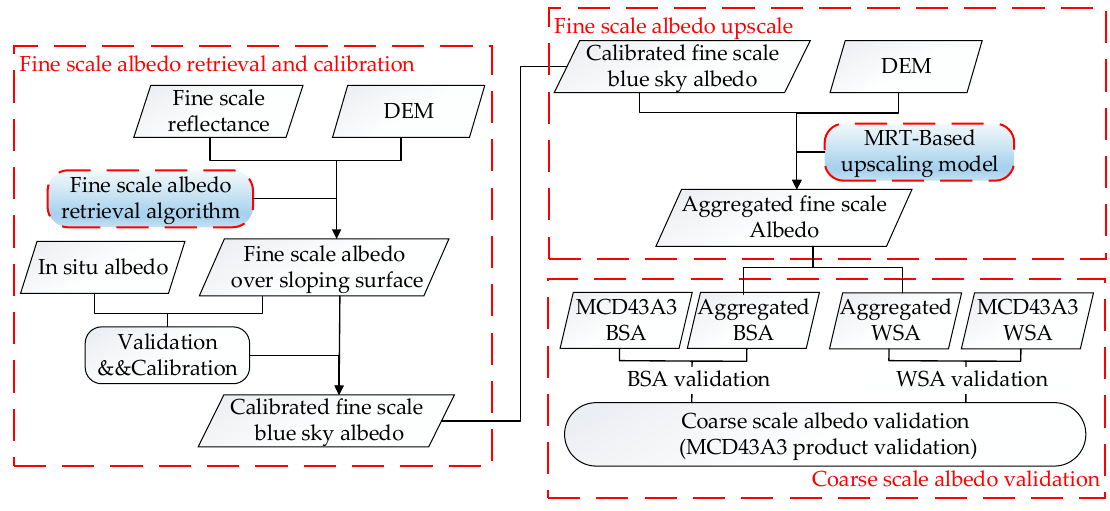
Figure 1. The coarse albedo validation procedure over rugged terrain.